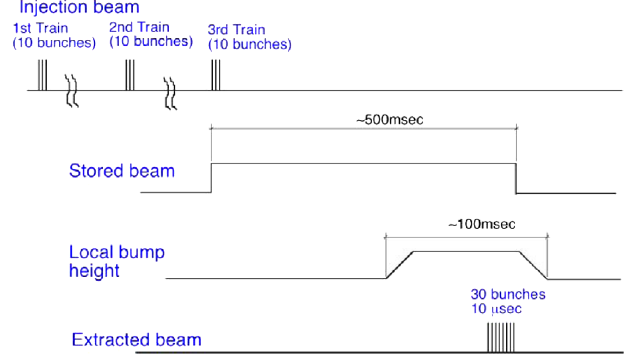
FIG. 5. Time sequence of the beam injection and extraction: (1) the three trains of the beam are injected to the DR; (2) the local bump orbit is excited gradually after the beam is damped; (3) the beam is kicked bunch by bunch at the end of the flattop of the bump orbit; and (4) the bump orbit returns to zero.